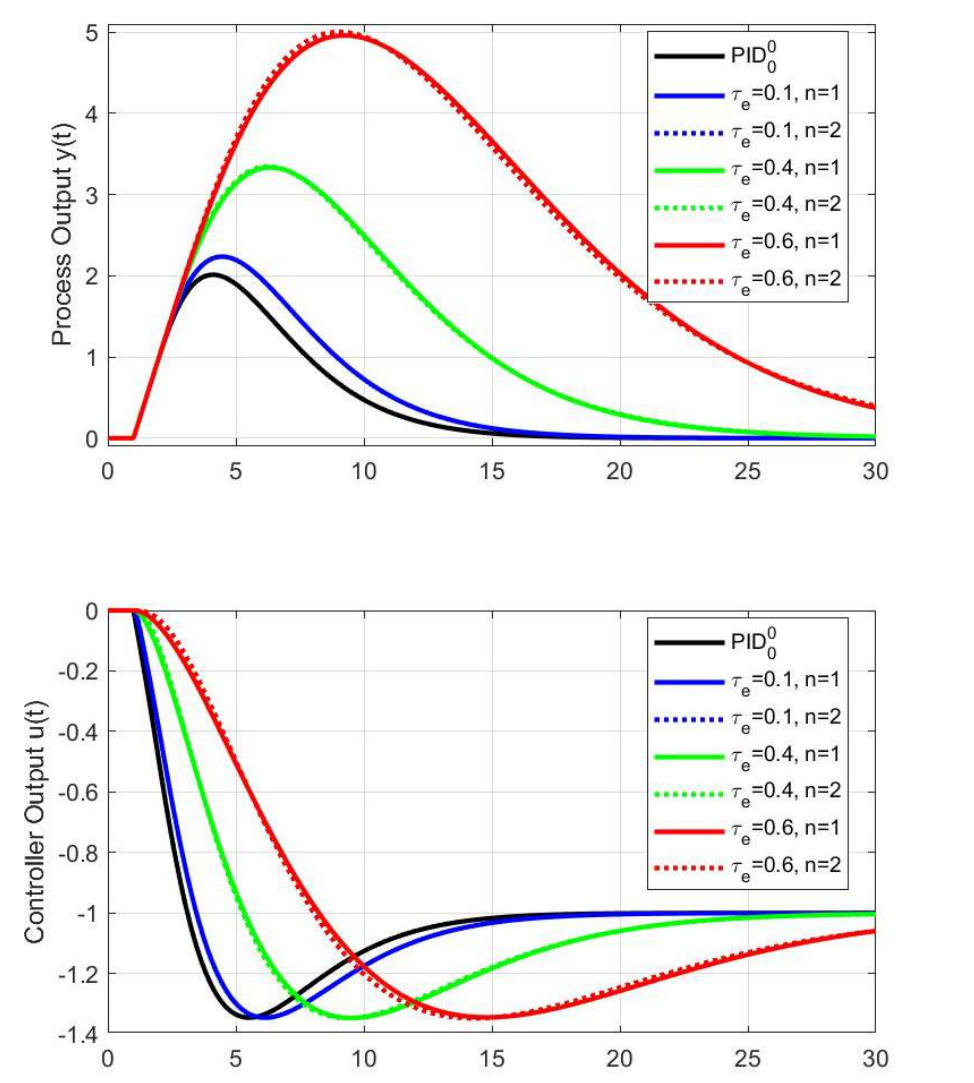
Figure 5. Verifying the dead-time and gain margins of the PID 0 the T f = T e /2 tuning